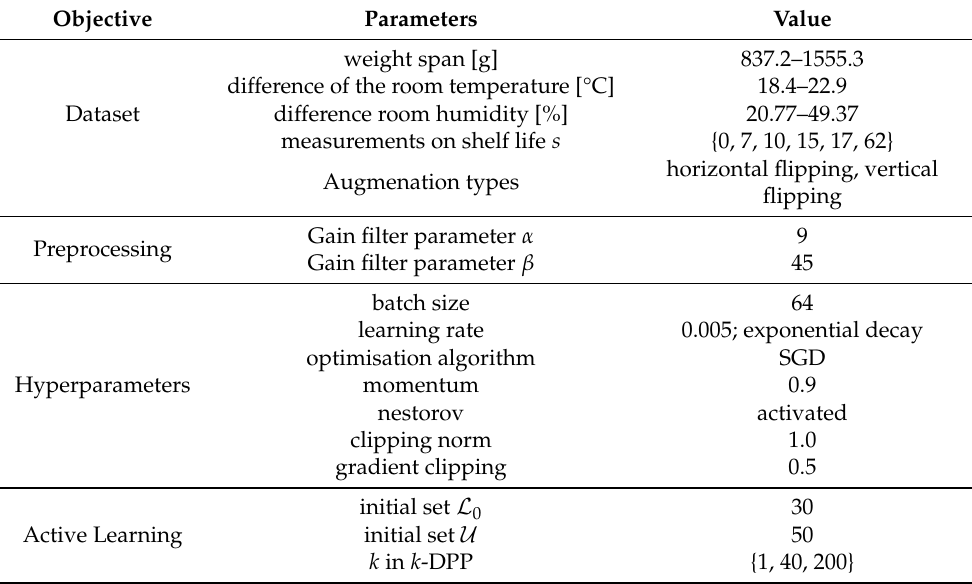
Table A1. Summary of all parameters taking impact on the training